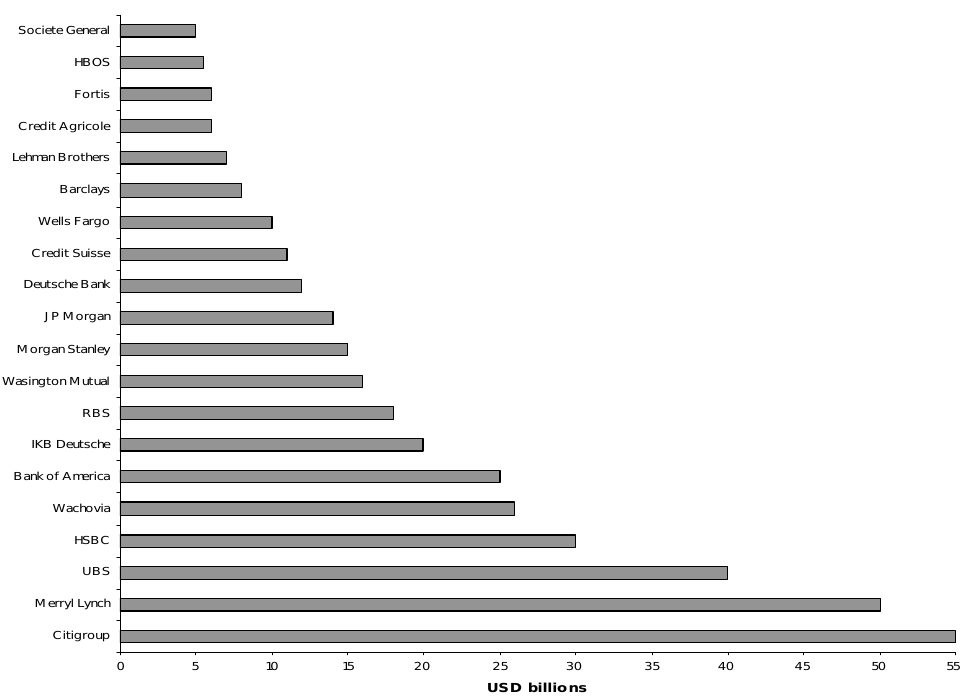
Largest bank write-downs since the beginning of